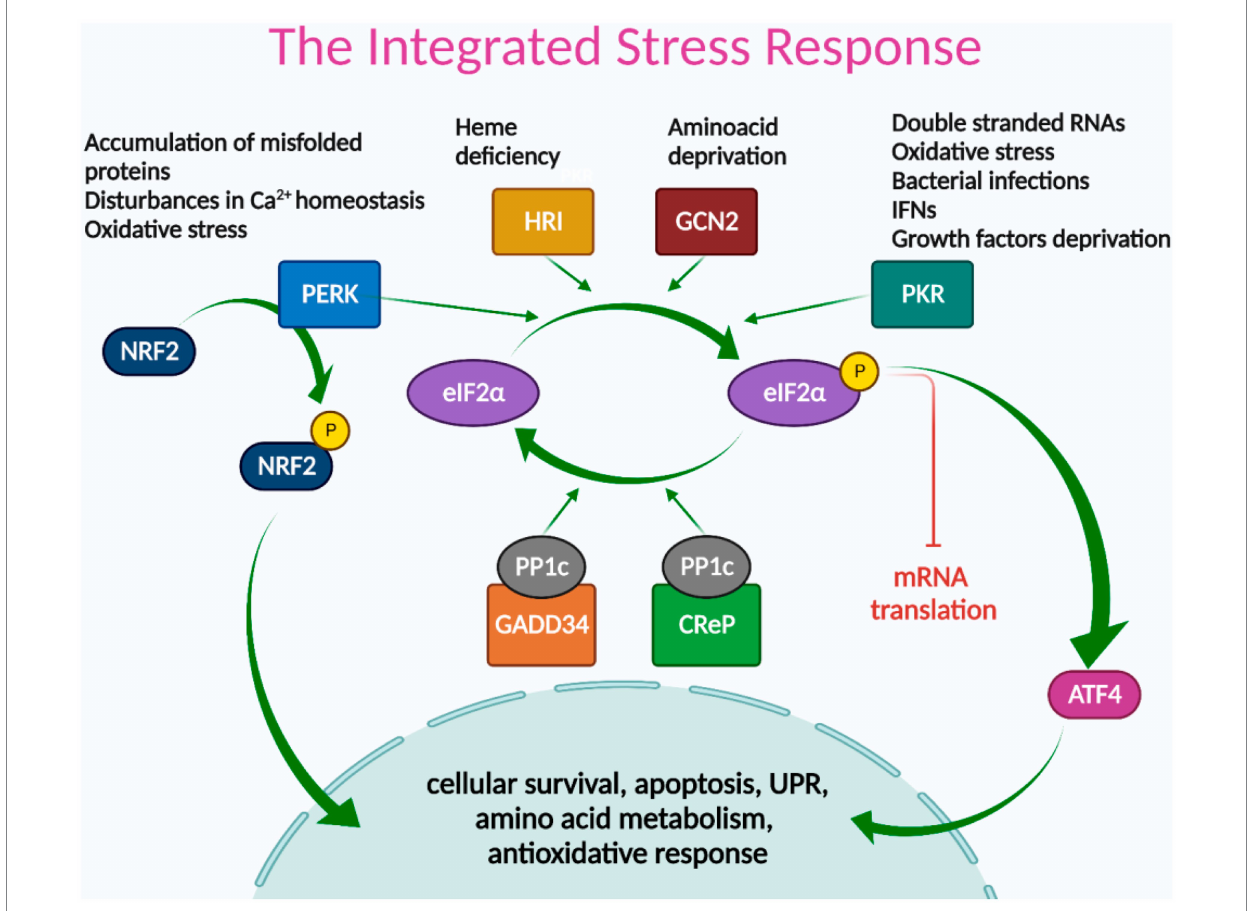
FIGURE 1 The integrated stress response signaling pathways. Different stress signals activate PERK, HRI, GCN2, or PKR kinases, which phosphorylate eIF2 α , leading to global attenuation of mRNA translation and promoting the translation of ISR-specific mRNAs, such as ATF4. ATF4 transcription factor acts as a master regulator of the ISR, inducing genes involved in cellular survival, apoptosis, UPR, amino acid metabolism, and redox reactions. NRF2 is another key transcription factor of the ISR, directly activated by PERK, and mainly involved in antioxidant responses. The termination signal of the ISR is regulated by phosphatase complex PP1c/GADD34 and/or PP1c/CReP that dephosphorylate eIF2 α to restore protein